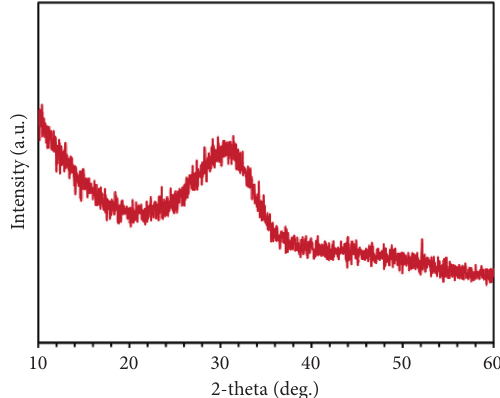
Figure 3: XRD pattern of slag material.